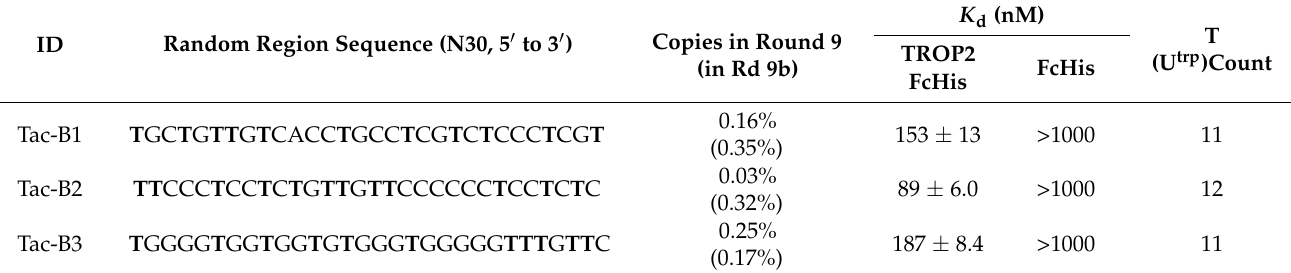
Table 2. Sequence information obtained with hybrid-type